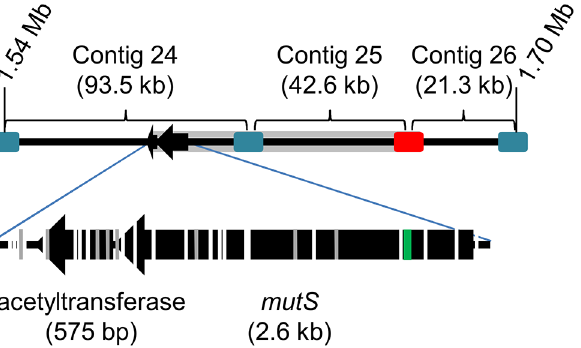
Fig 1. ~60 kb deletions begin near and extend into mutS to confer the hypermutator phenotype. The top line demonstrates contigs 24 – 26 separated by mobile elements IS Aba-1 (blue) and IS15 D1 (red) and the deleted region (gray). The genomic position of the region can be compared to Figs 2C and 4C. In the lower portion of the figure, the mutS gene is enlarged to identify IS15 D1 insertion sites. White breaks in mutS and the adjacent gene indicate positions where IS15 D1 inserted in one or more polymorphic samples. Gray lines mark where IS15 D1 inserted in the clonal isolates. The deletion in clinical isolate AB211 is indicated